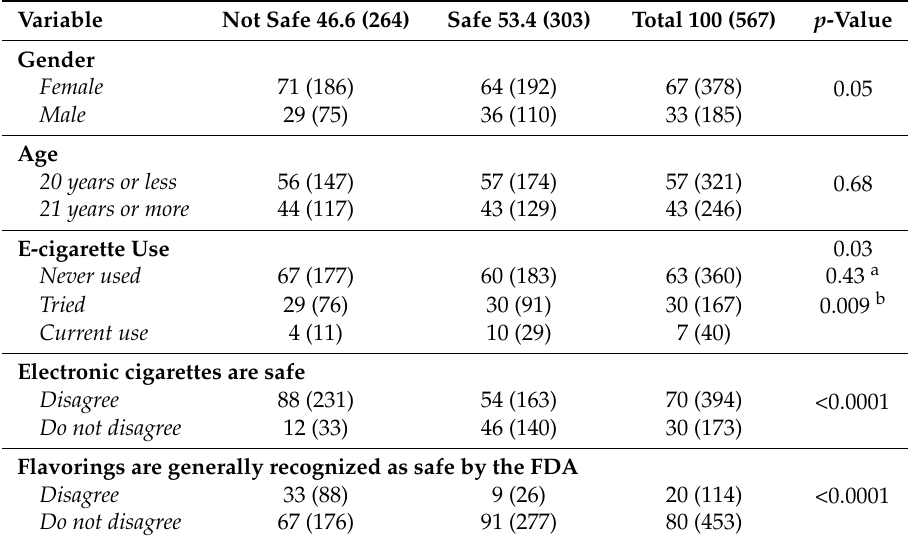
Table 1. Perception of e-cigarette flavoring safety- % ( n